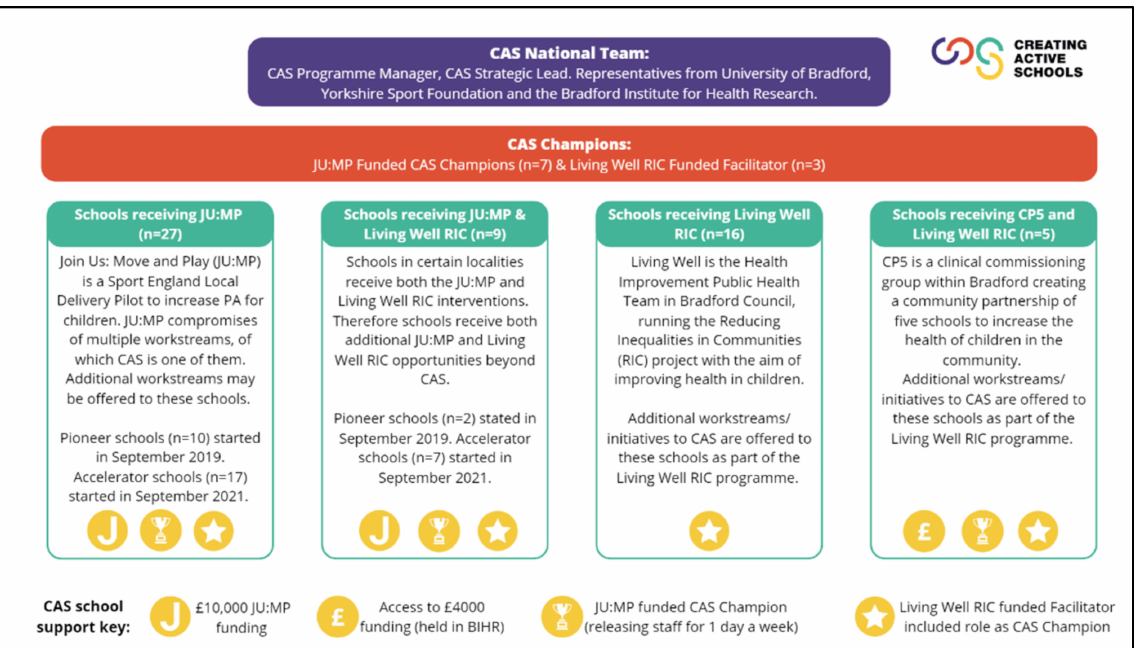
Figure 1. The delivery model of CAS within